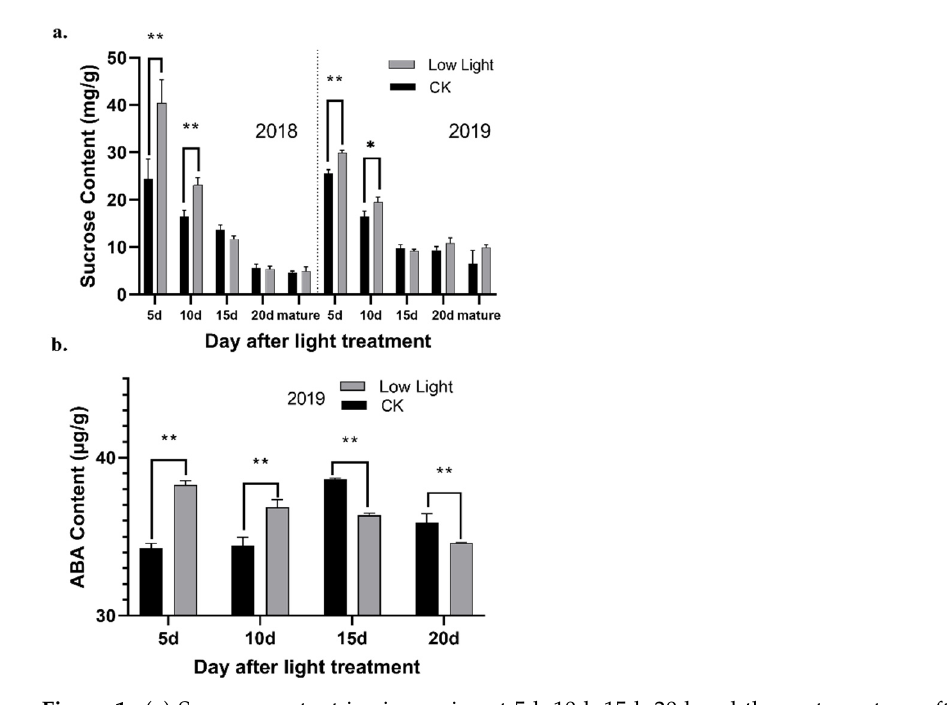
Figure 1. ( a ) Sucrose content in rice grains at 5d, 10d, 15d, 20d and the mature stage after light treatment in 2018 and 2019; ( b ) contents of ABA in rice grains at 5d, 10d, 15d, and 20d after light treatment in 2019. CK: normal light. * and ** indicates significance at p ≤ 0.05 and p ≤ 0.01.